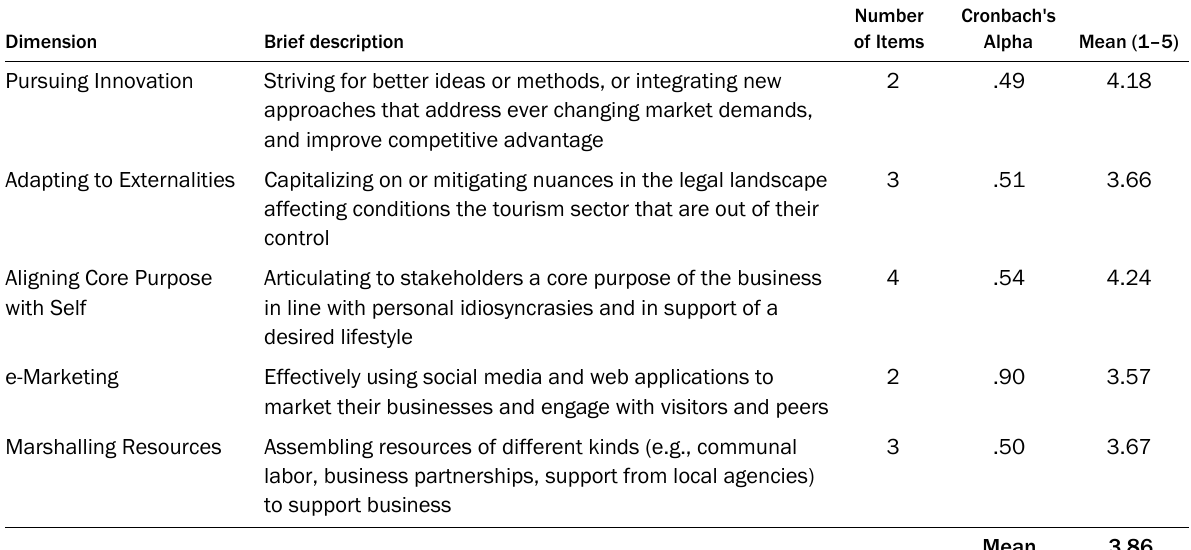
Table 1. Descriptive Statistics and Reliability for Microentrepreneurs’ TeMSE